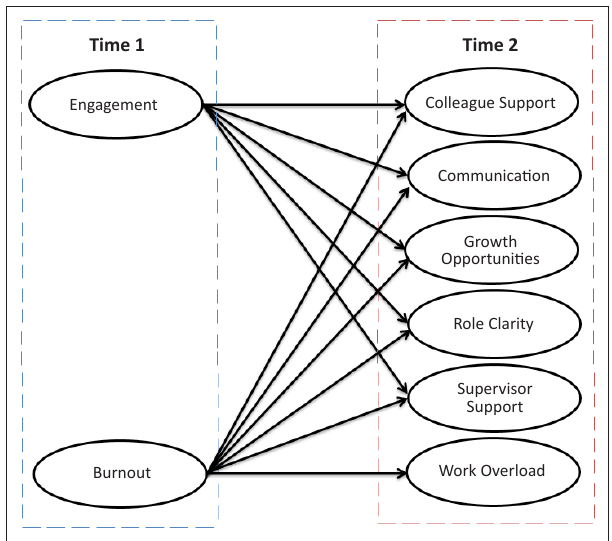
FIGURE 1: Illustration of reversed causal hypotheses under investigation.